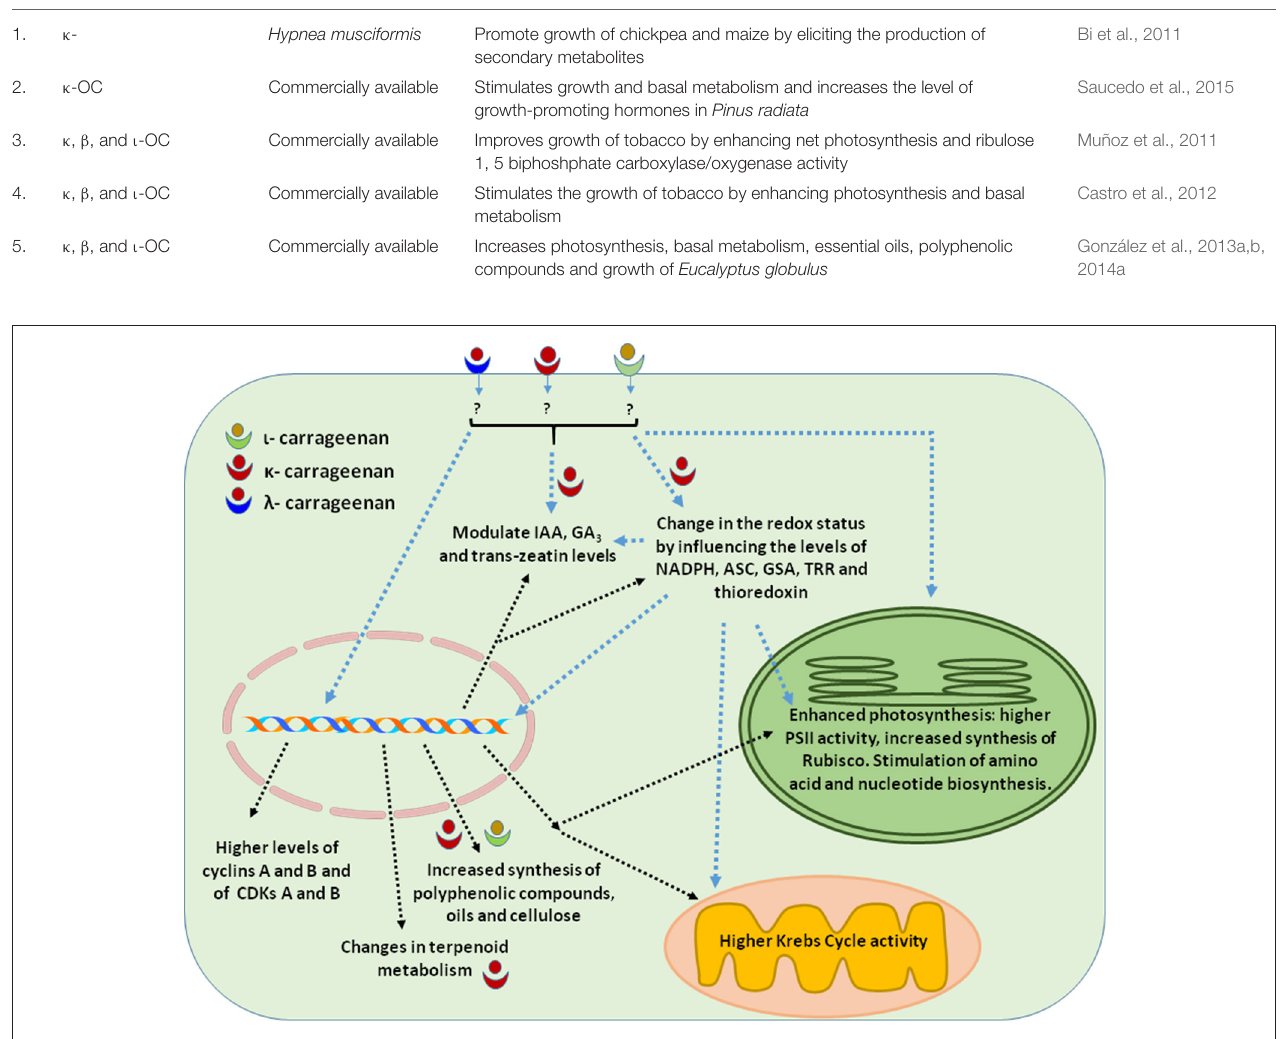
FIGURE 1 | Cellular activities elicited by carrageenans applications that resulted in enhanced plant growth. The drawing summarizes most of the information presented in Section Plant